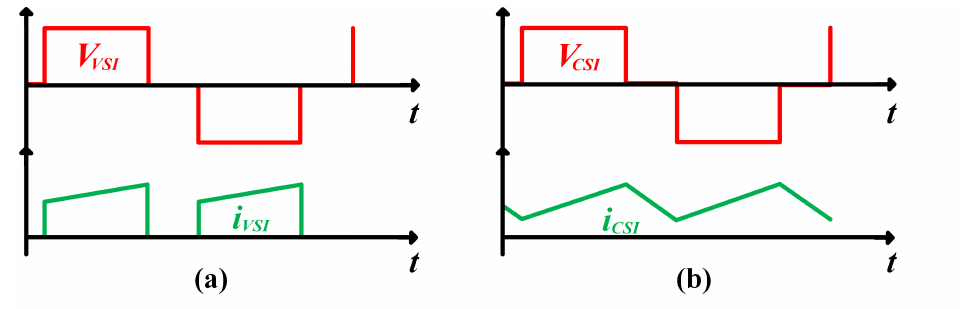
Figure 11. Voltage and current representation over one switching period at the entrance of the inverter: ( a ) VSI and ( b )